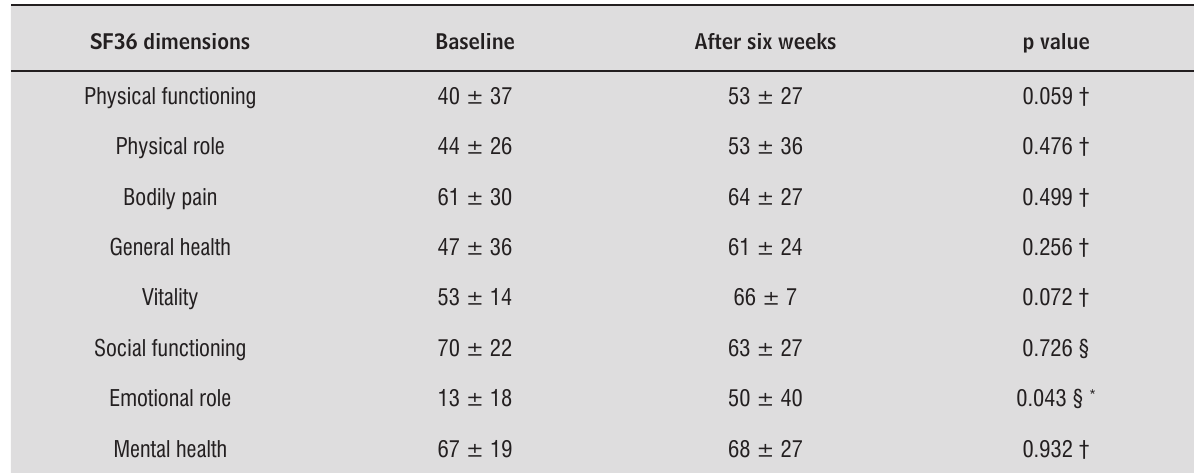
Table 2 - Quality of life scores obtained at baseline and after six weeks of rehabilitation based on physical exercises